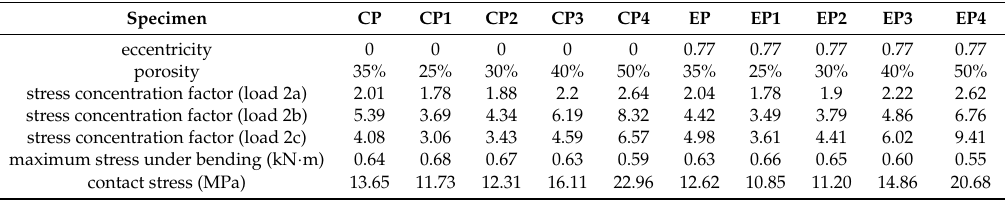
Table 3. Comparison of the stress concentration factor under different